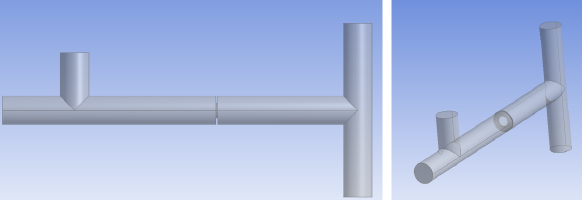
Figure 7: Three-dimensional model of the installation fragment with a measuring orifice